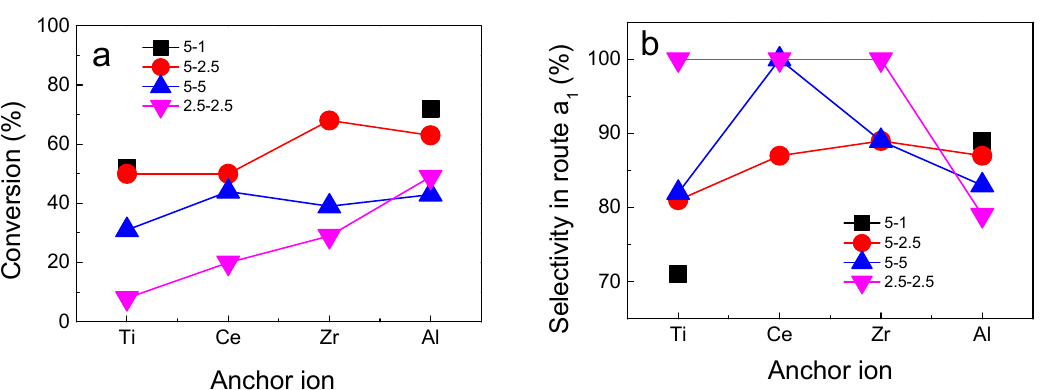
Figure 5. Effects of anchor type and metal loading on conversion ( a ) and selectivity to route a 1 ( b ) for all the catalysts. (Symbols correspond to different V to M anchor ratios, (n–x)VM-MS-L/T-cal (M = Ti, Ce, Zr, and Al.)